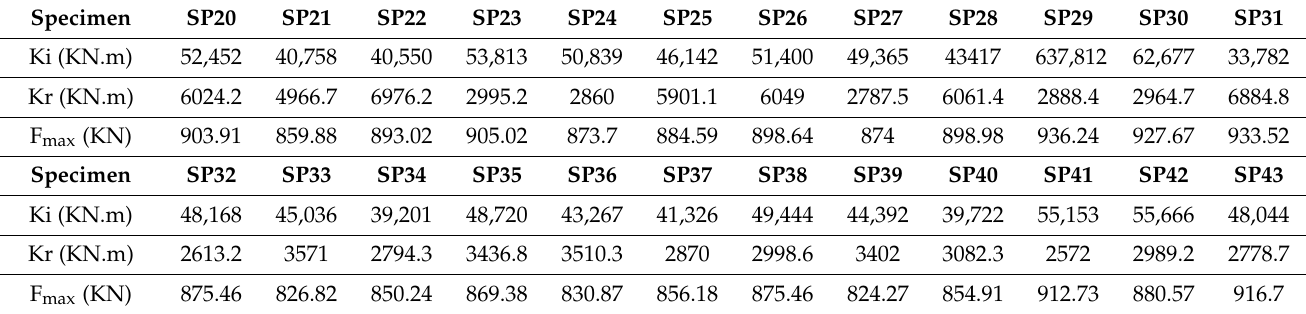
Table 9. The parameters of the response